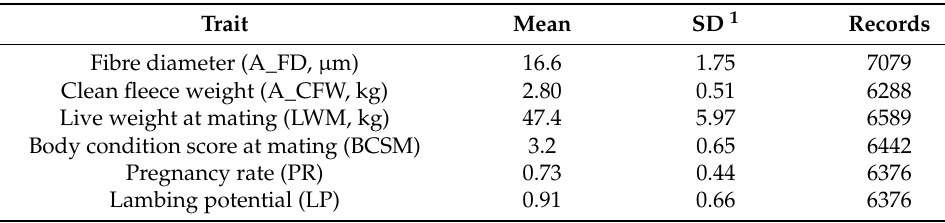
Table 1. Descriptive statistics for the wool, body growth and reproduction traits of mixed-age ewes born between 1999 and